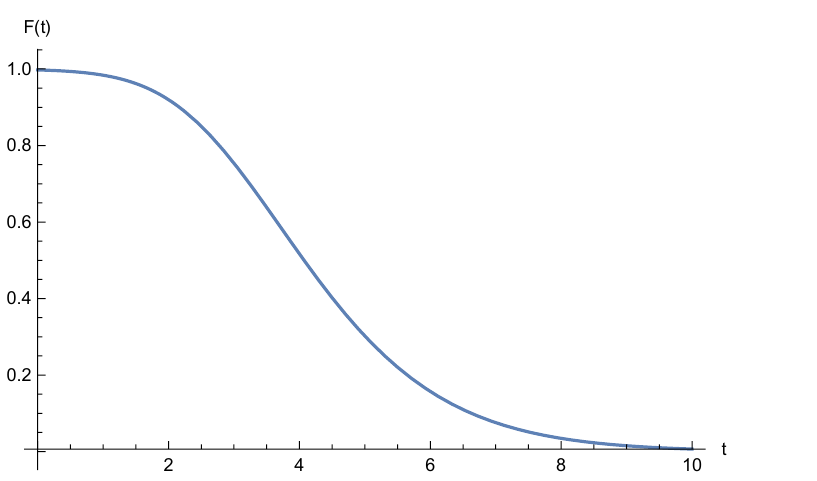
Figure 6 . The out-of-time-order correlator h V R (0) W R ( t ) V R (0) W R ( t ) i for j g ( t = 0) j = 10 ; ‘ = 1. An imaginary part of the